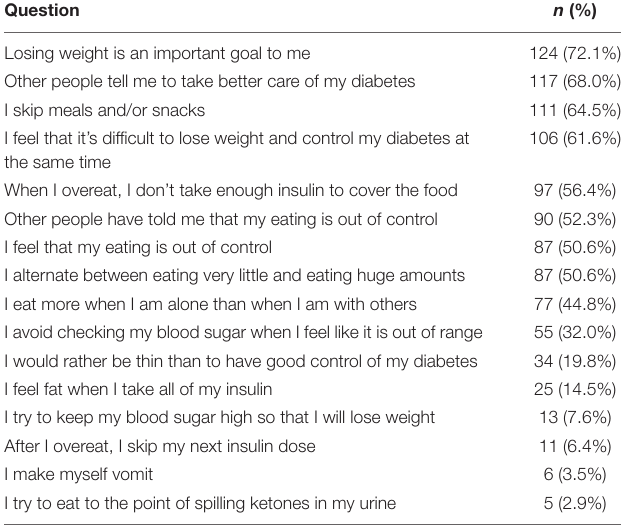
TABLE 4 | DEPS-R items endorsed.